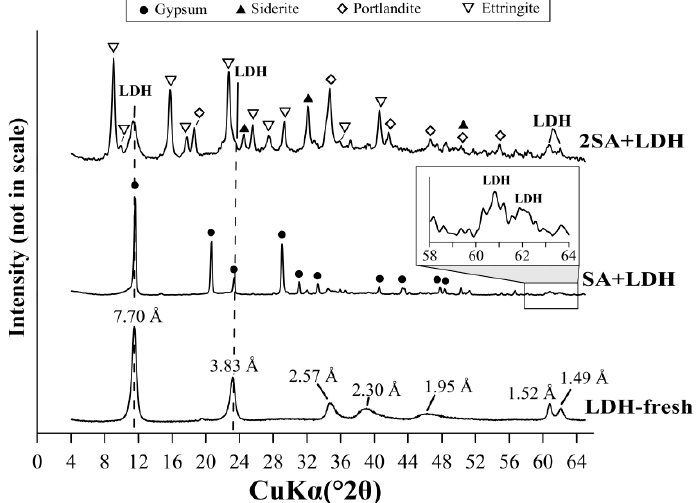
Figure 10. The XRD patterns of solid phases formed as a result of AMD treatment by mixtures of SA + LDH, 2SA + LDH, and LDH, before AMD treatment, as a reference sample.